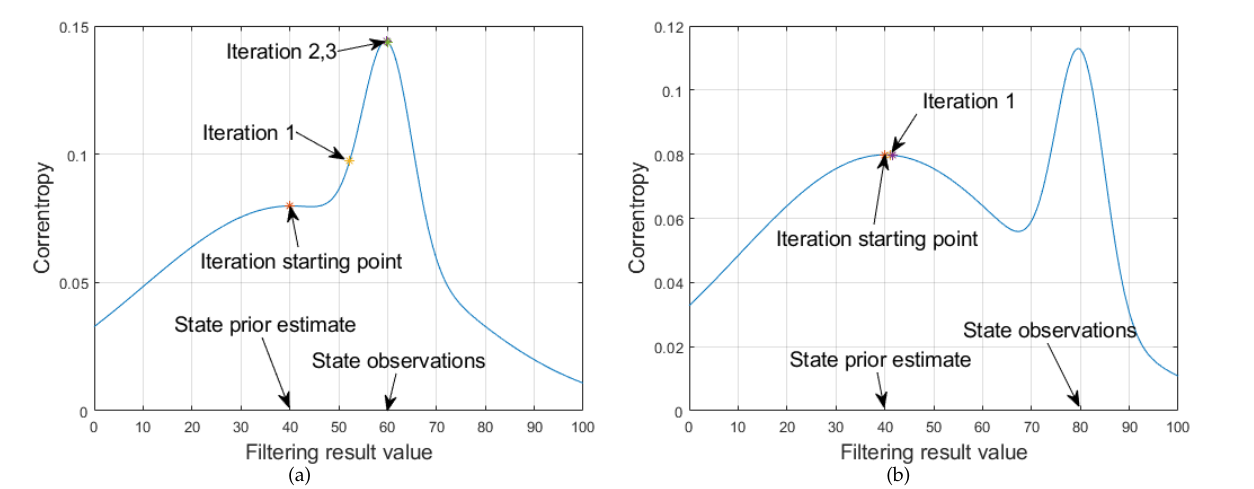
Figure 1. Distribution of correntropy in different scenes. ( a ) Distribution of correntropy when parameters are accurate; ( b ) distribution of correntropy when NGN